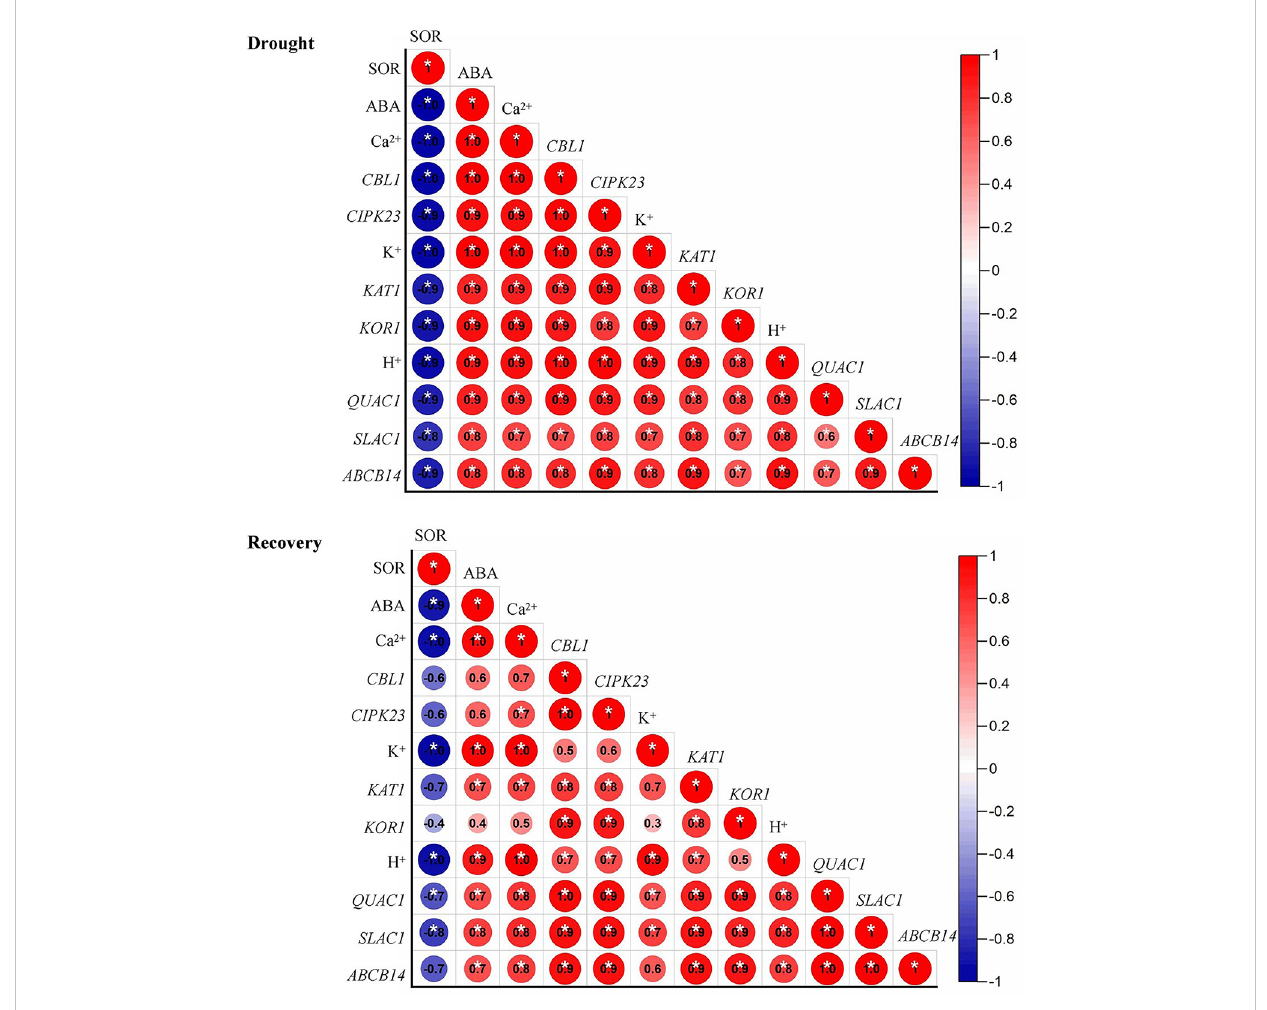
FIGURE 9 Correlation analysis among physiological parameters under drought stress (A) and recovery (B) . SOR, stomatal opening rate. Correlations are expressed using Pearsons coef fi